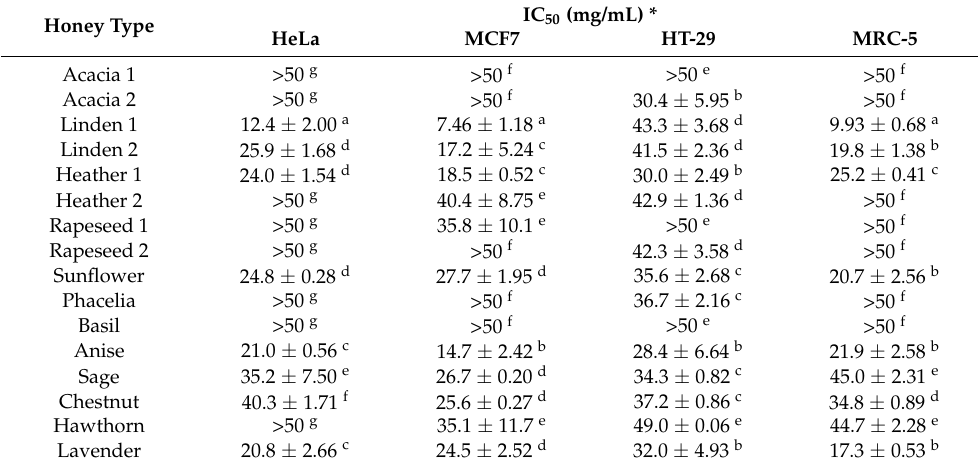
Table 5. Effects of honey samples on the growth of selected human cell